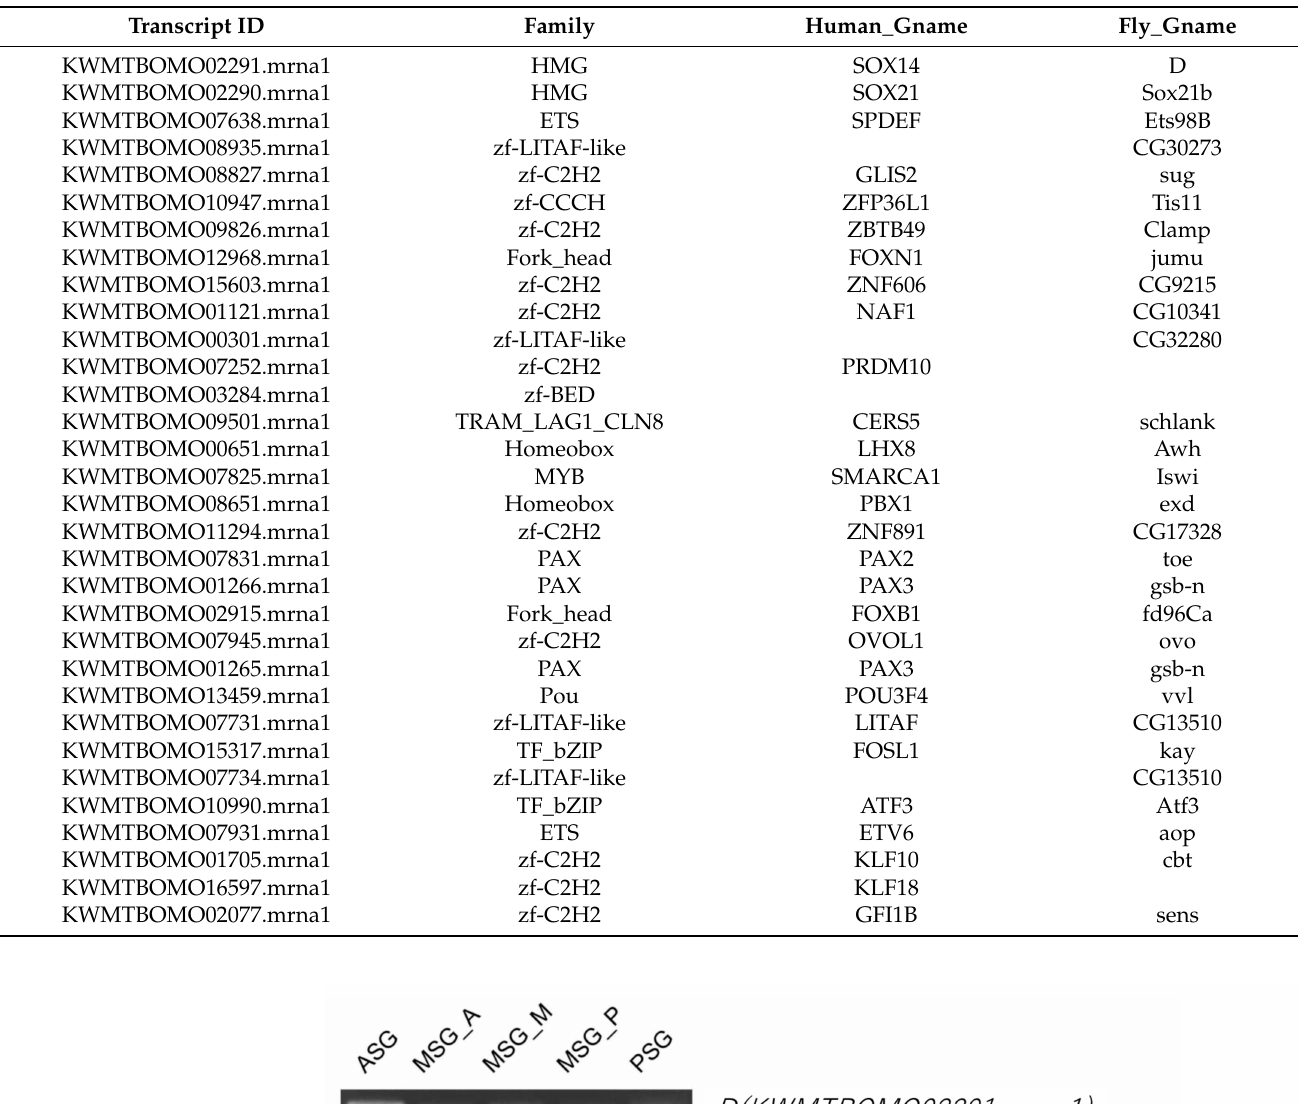
Table 2. List of transcription factors expressed in the silk gland (more detailed data was in Table S9). human_gname and fly_gname indicate functional annotations against human and fly genomes, respectively, shown in Data S3.